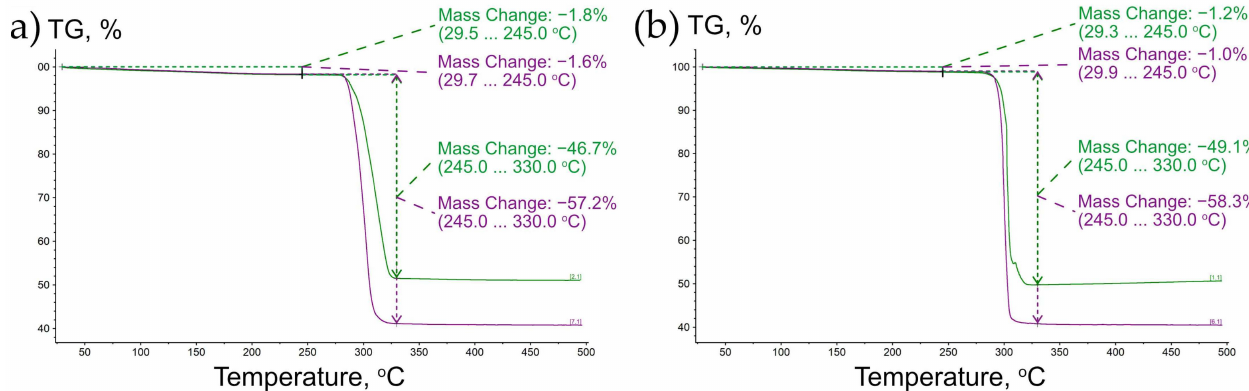
Figure 12. Thermal decomposition of SM powder samples that were synthesized at room temperature ( a ) and at 60 ◦ C ( b ); see Section 4.1 for details. Legend: heating in inert (violet) and oxidizing (green)